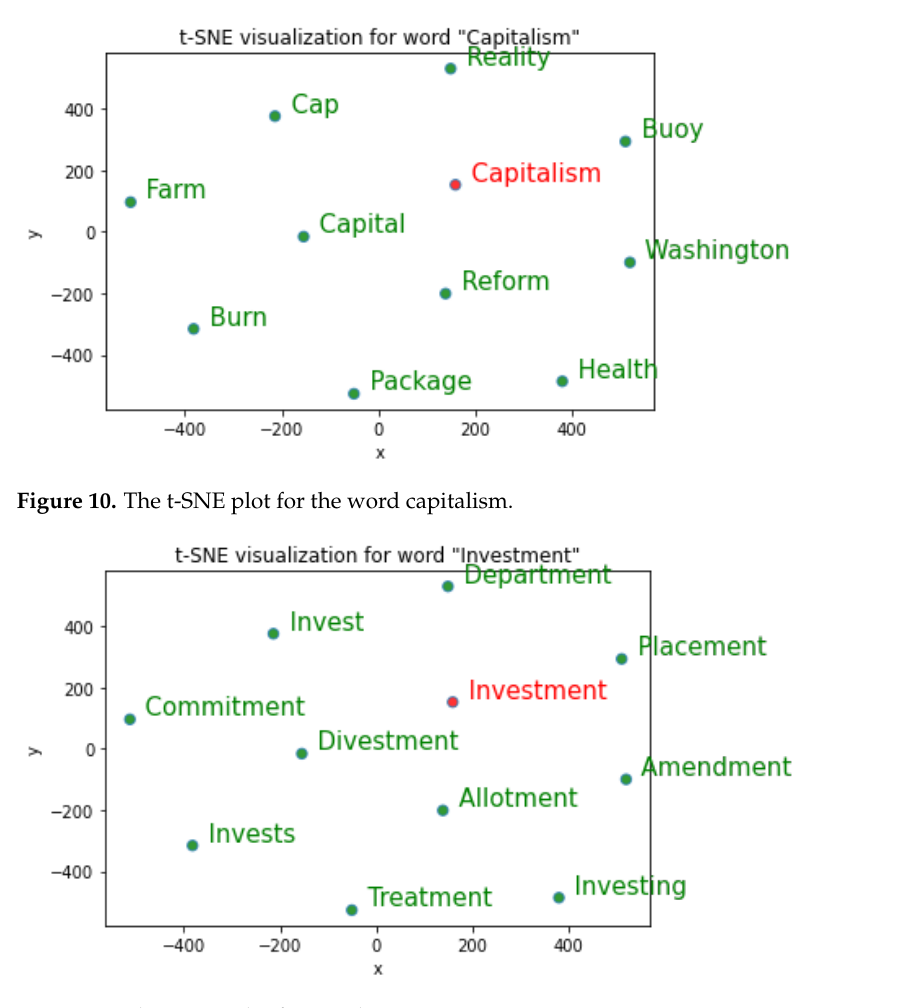
Figure 11. The t-SNE plot for word